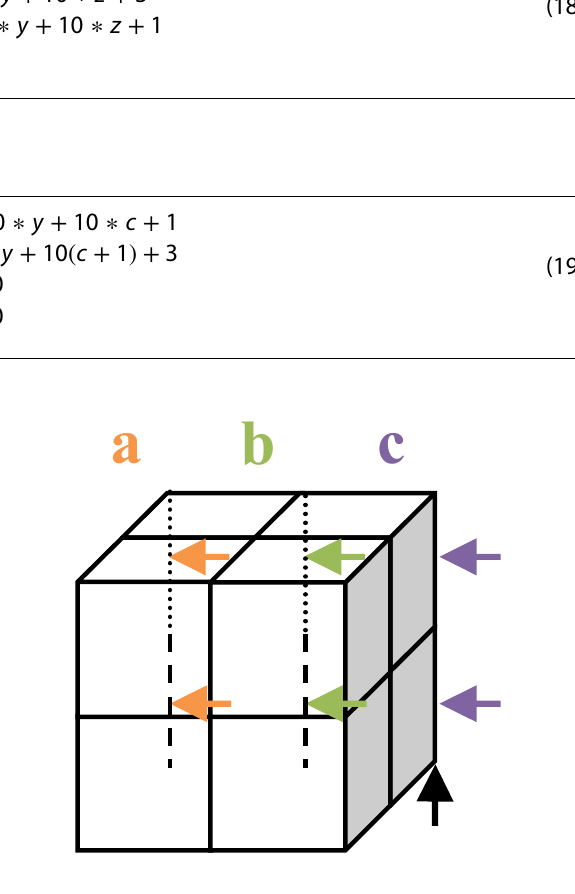
Fig. 19 Illustration of the Joint-Z joints when y = b +